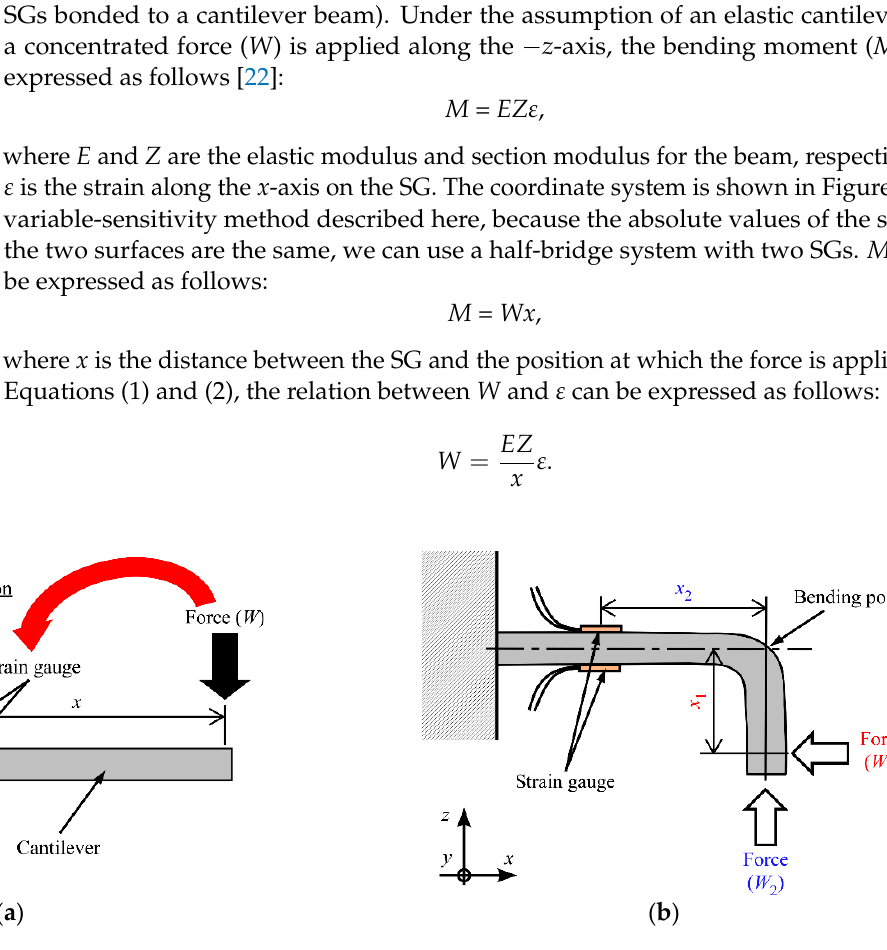
Figure 1. Bending state of beam. ( a ) Original shape. ( b ) Deformed and fixed shape.